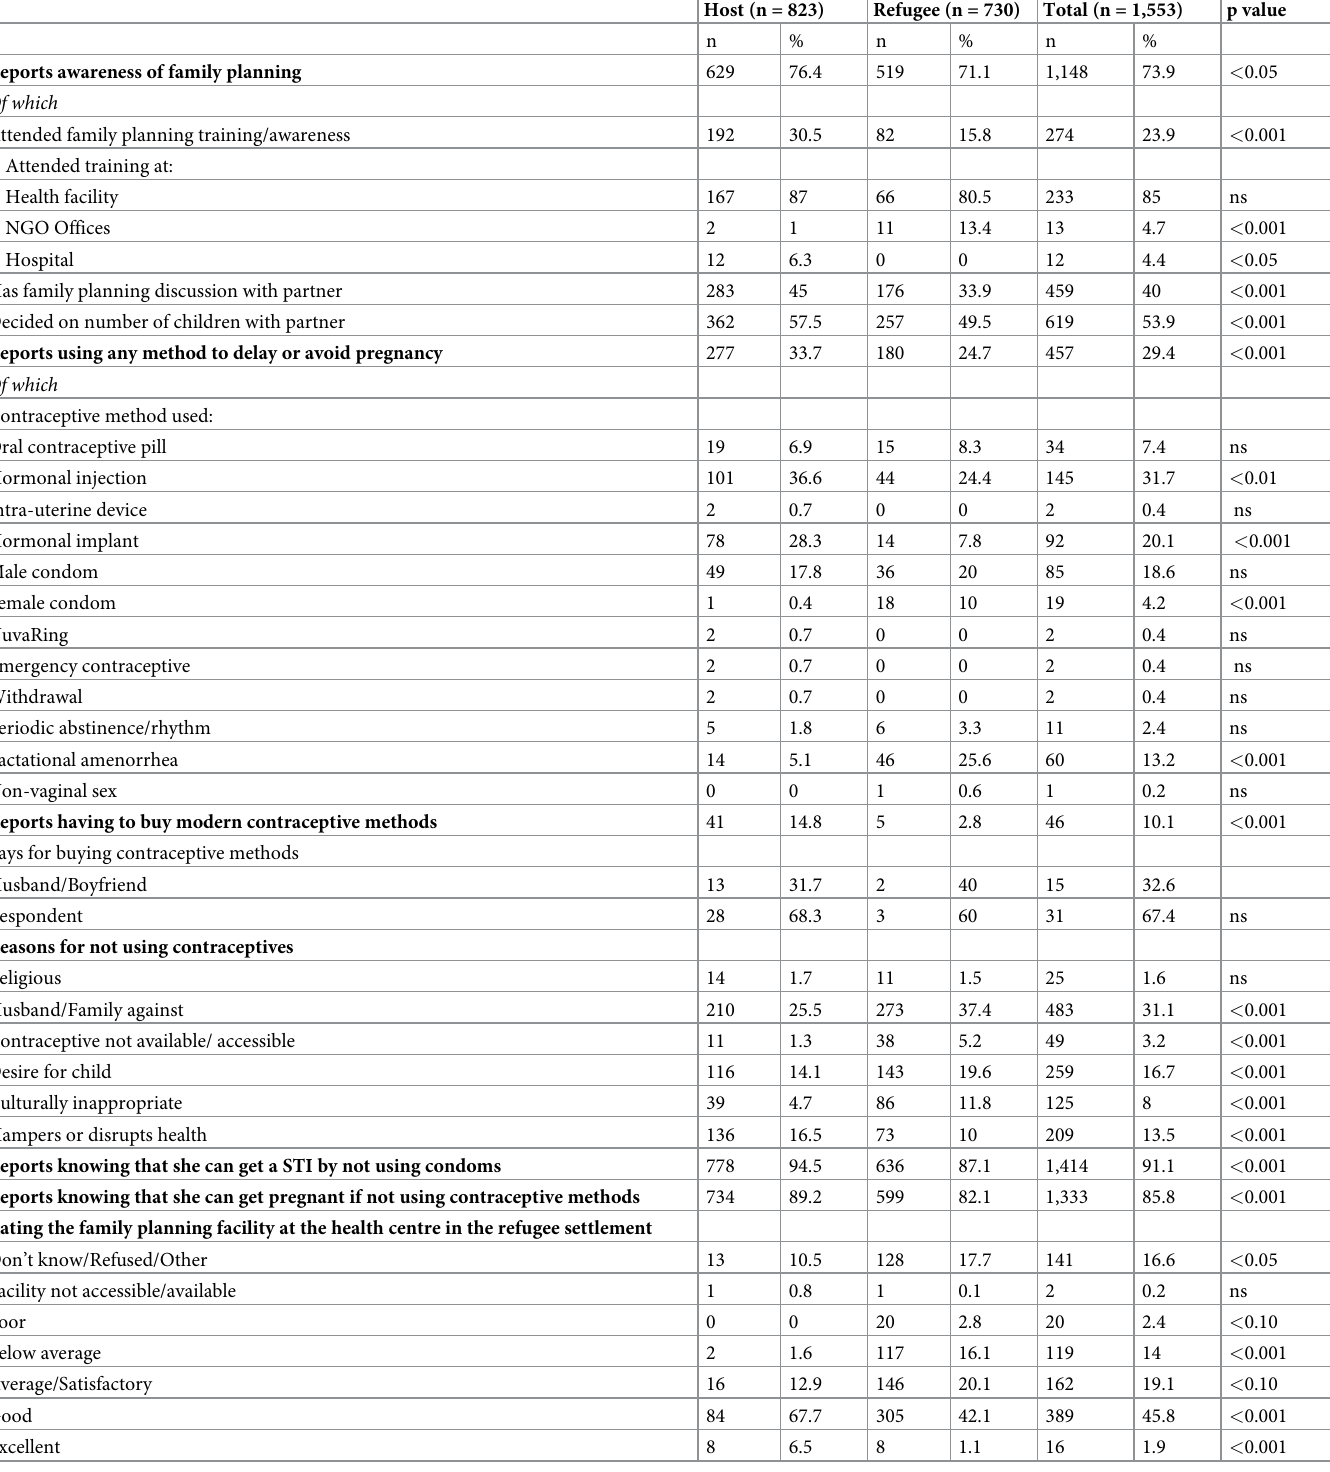
Table 4. Results from cross-sectional survey on modern family planning knowledge and use amongst partnered South Sudanese refugee and Ugandan women in Kiryandongo and Arua, Northern Uganda. Host (n = 823) Refugee (n = 730) Total (n =